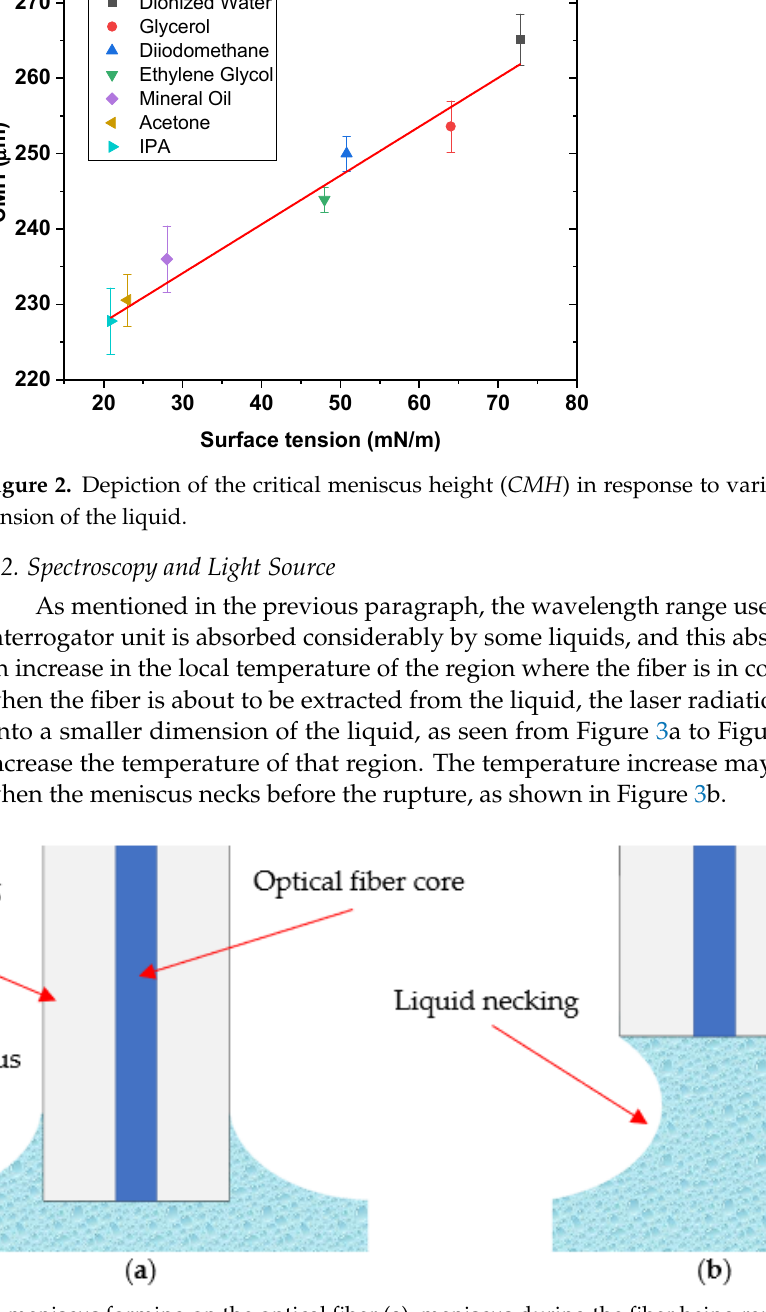
Figure 3. Depiction of the meniscus forming on the optical fiber ( a ), meniscus during the fiber being removed ( b ).